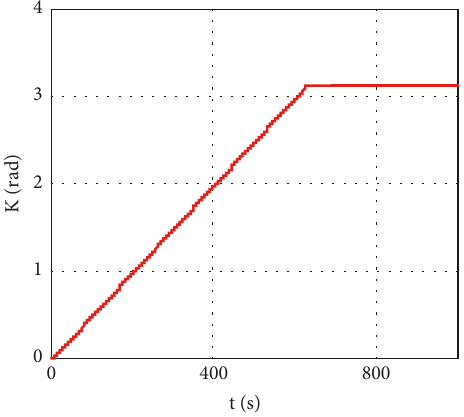
Figure 7: Time dependence of the vessel heading angle during rotation towards the return course for 𝑧 ∗ 3 = 0.005𝑟𝑎𝑑 ⋅ 𝑠 −1 , 𝑧 ∗ 6 =